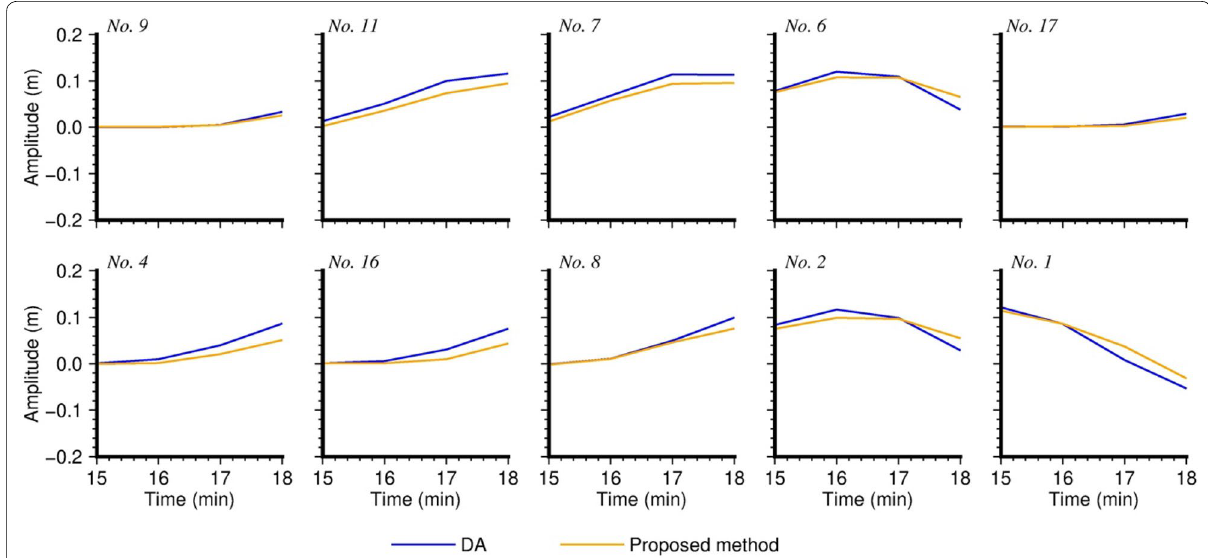
Fig. 6 Comparisons of waveforms between the proposed method and DA at ten randomly selected stations of the dense observational stations for the simple bathymetry case. The location of the selected stations is shown in Fig. 3